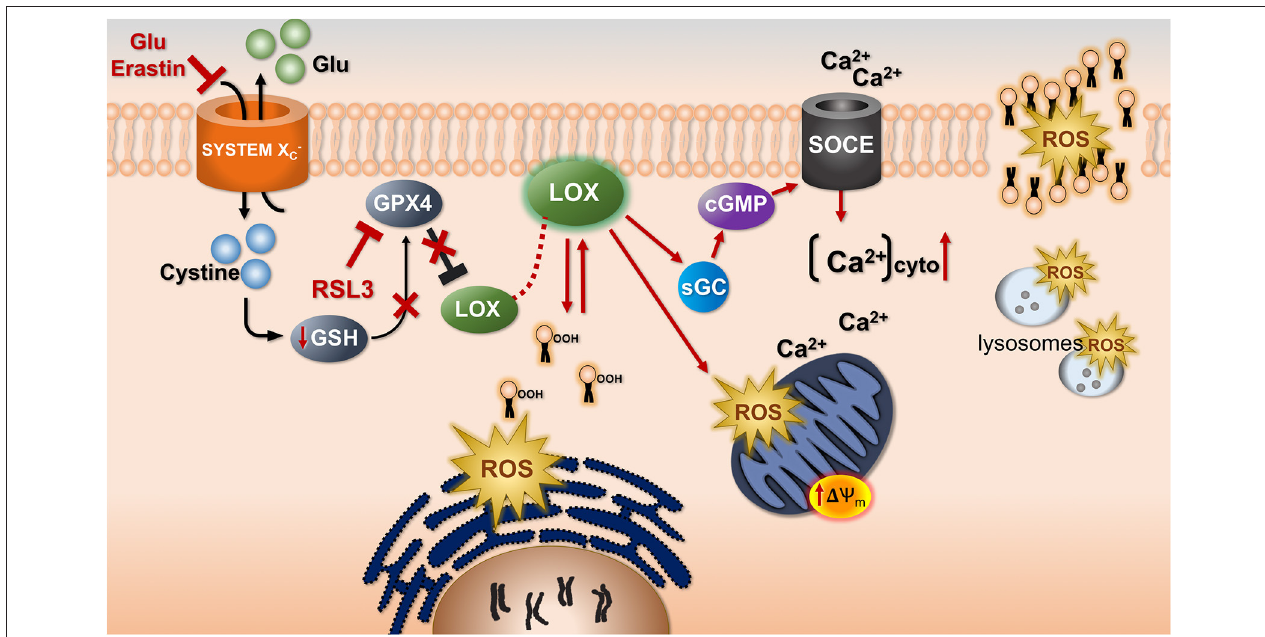
FIGURE 4 | The common cell death pathway in oxytosis and ferroptosis. Uptake of cystine by system x − c associated with counter-transport of glutamate (Glu) is inhibited by Glu and Erastin. This leads to depletion of glutathione (GSH) and subsequently inhibition of the GSH-dependent enzyme GSH peroxidase 4 (GPX4). GPX4 can also be directly inhibited by RSL3. GPX4 inhibition leads to activation of LOX. As a result, lipid hydroperoxides (lipid icons with OOH) accumulate probably in or very close to the endoplasmic reticulum as the initiating step of the production of reactive oxygen species (ROS). There is exponentially increasing mitochondrial ROS production associated with a hyperpolarization of the mitochondrial membrane potential ( 19 m). Whether this is a direct effect of LOX is unknown. However, via activation of soluble guanylate cyclase (sGC) induced by LOX metabolites cGMP accumulates and calcium influx through store-operated calcium channels (SOCE) is activated. This increases cytoplasmic calcium (Ca 2 + ) cyto . There is a mutual requirement for ROS and calcium to reach their maximal levels. Lysosomes also contribute to the overall ROS